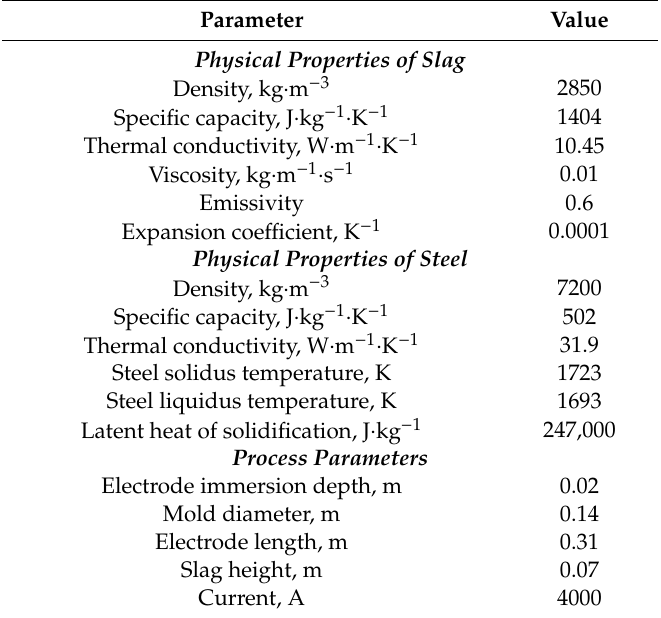
Figure 4. Numerical simulation flow charts. ( a ) Multi-physical steady-state model. ( b ) Transient model of electrode melting and droplet dropping. ( c ) Multi-phase transient model of molten metal pool. Table 1. Physical properties and geometric parameters for the simulation.